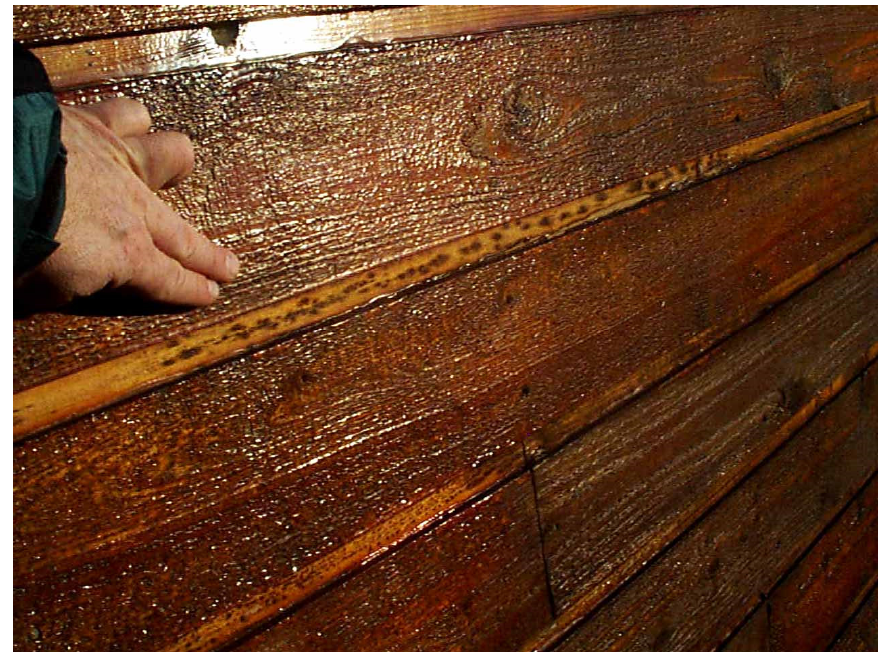
Figure 3. Scanning electron micrographs showing ( a ) fungal spores and hyphae growing on the surface of a new coating surface and ( b ) fungal spores and hyphae growing on an aged coating surface containing microcracks that can be exploited by fungal hyphae (Goodell images).